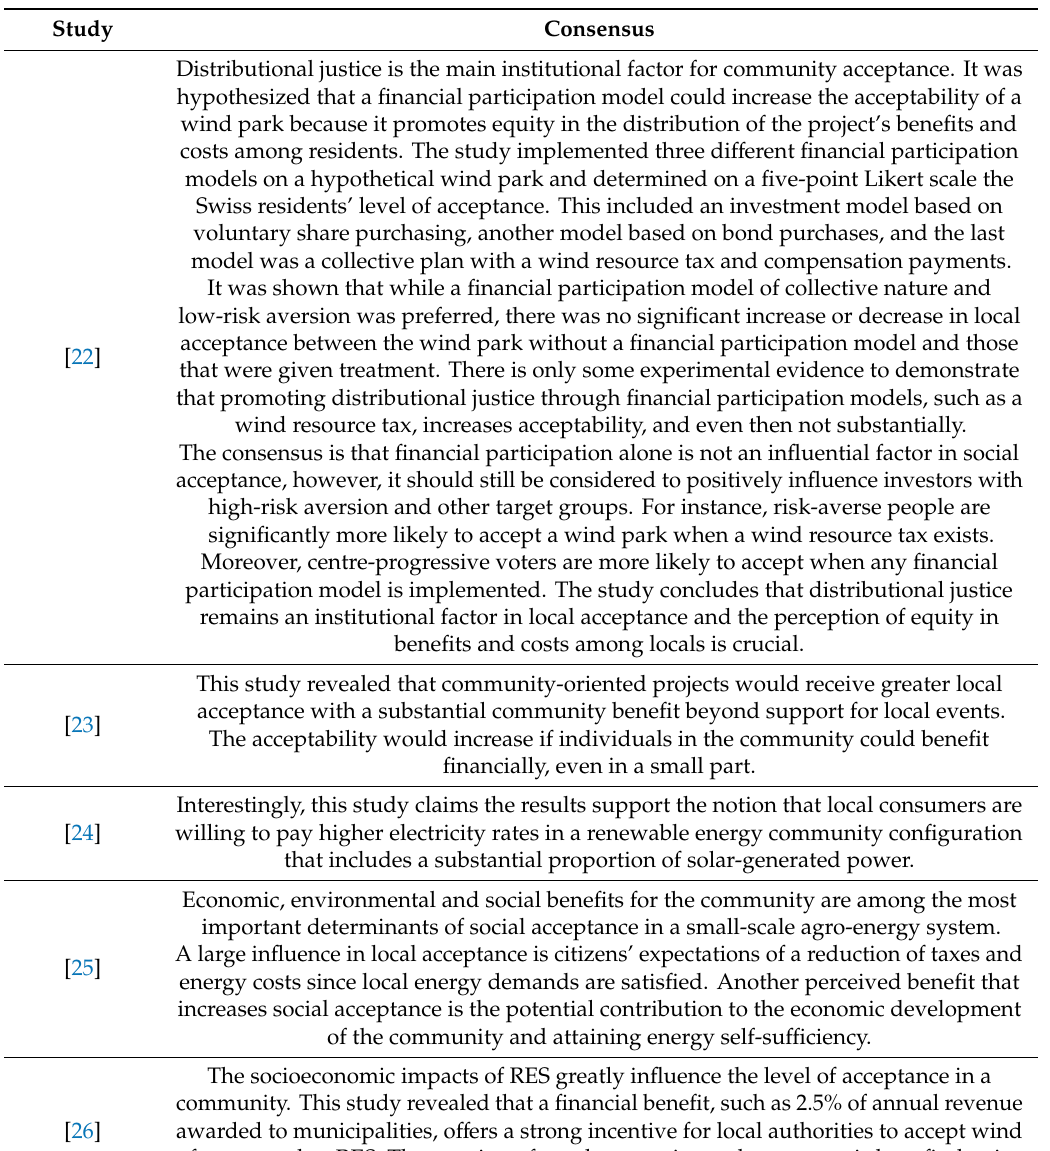
Table 3. Comparing the results of the e ff ect of distributional justice and economic interest on social